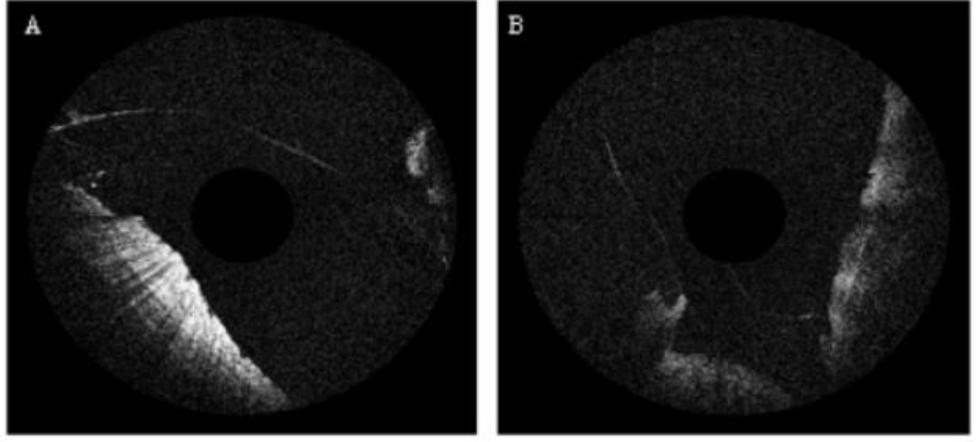
Figure 6. Stripe-like patterns in BE. ( A ) shows the obvious stripe pattern within a non-dysplastic BE endoscopic OCT image (EOCT); ( B ) shows no obvious stripe pattern within a high-grade dysplastic BE EOCT image [70].